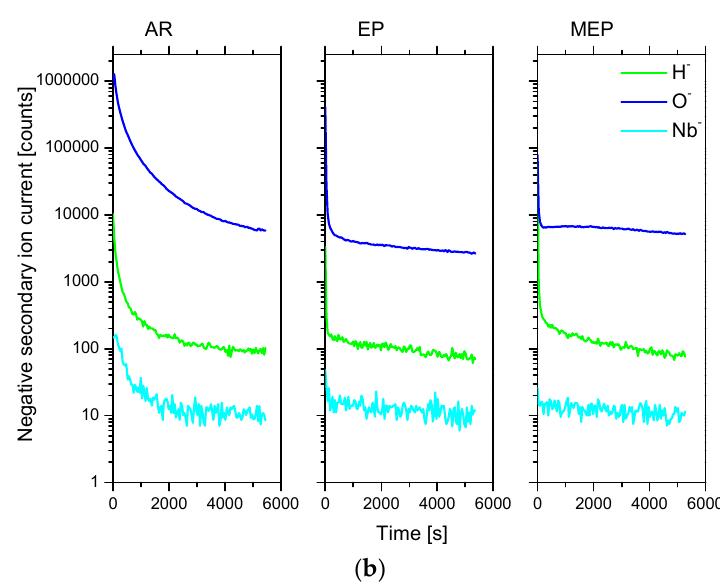
Figure 3. Rough results of SIMS depth analyses for positive ( a ), and negative ( b ) ions studies. The values of currents of the secondary ions vs. etching time are presented (at the electron beam of the energy of 5 keV). The ion etching area: 2 × 2 mm, analysis area: 0.8 × 0.8 mm. Three niobium samples were studied: AR, EP, and MEP.